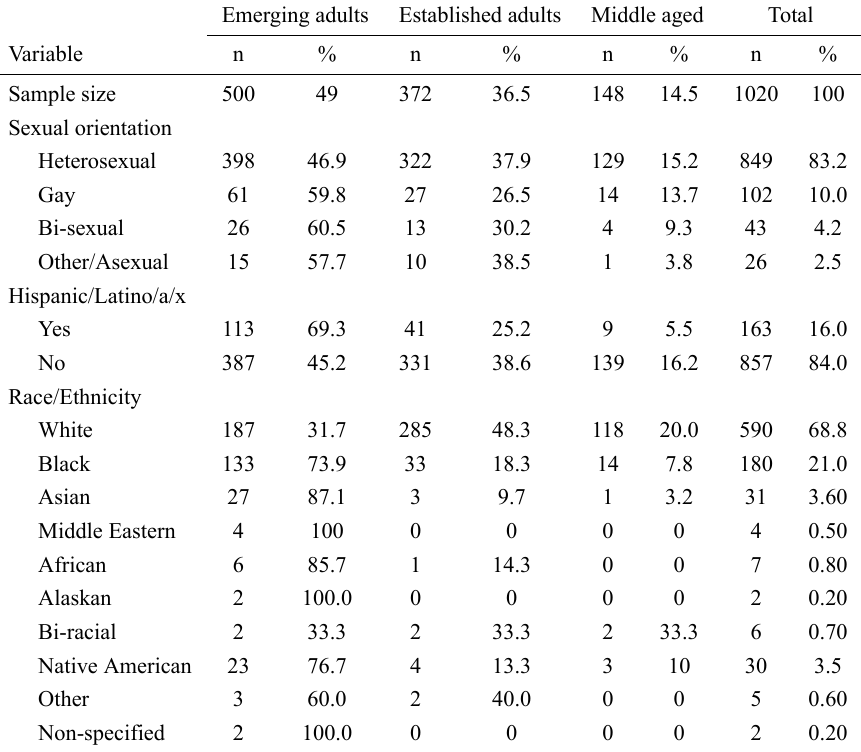
Table 1. Descriptive statistics and between group comparisons for age cohort. Emerging